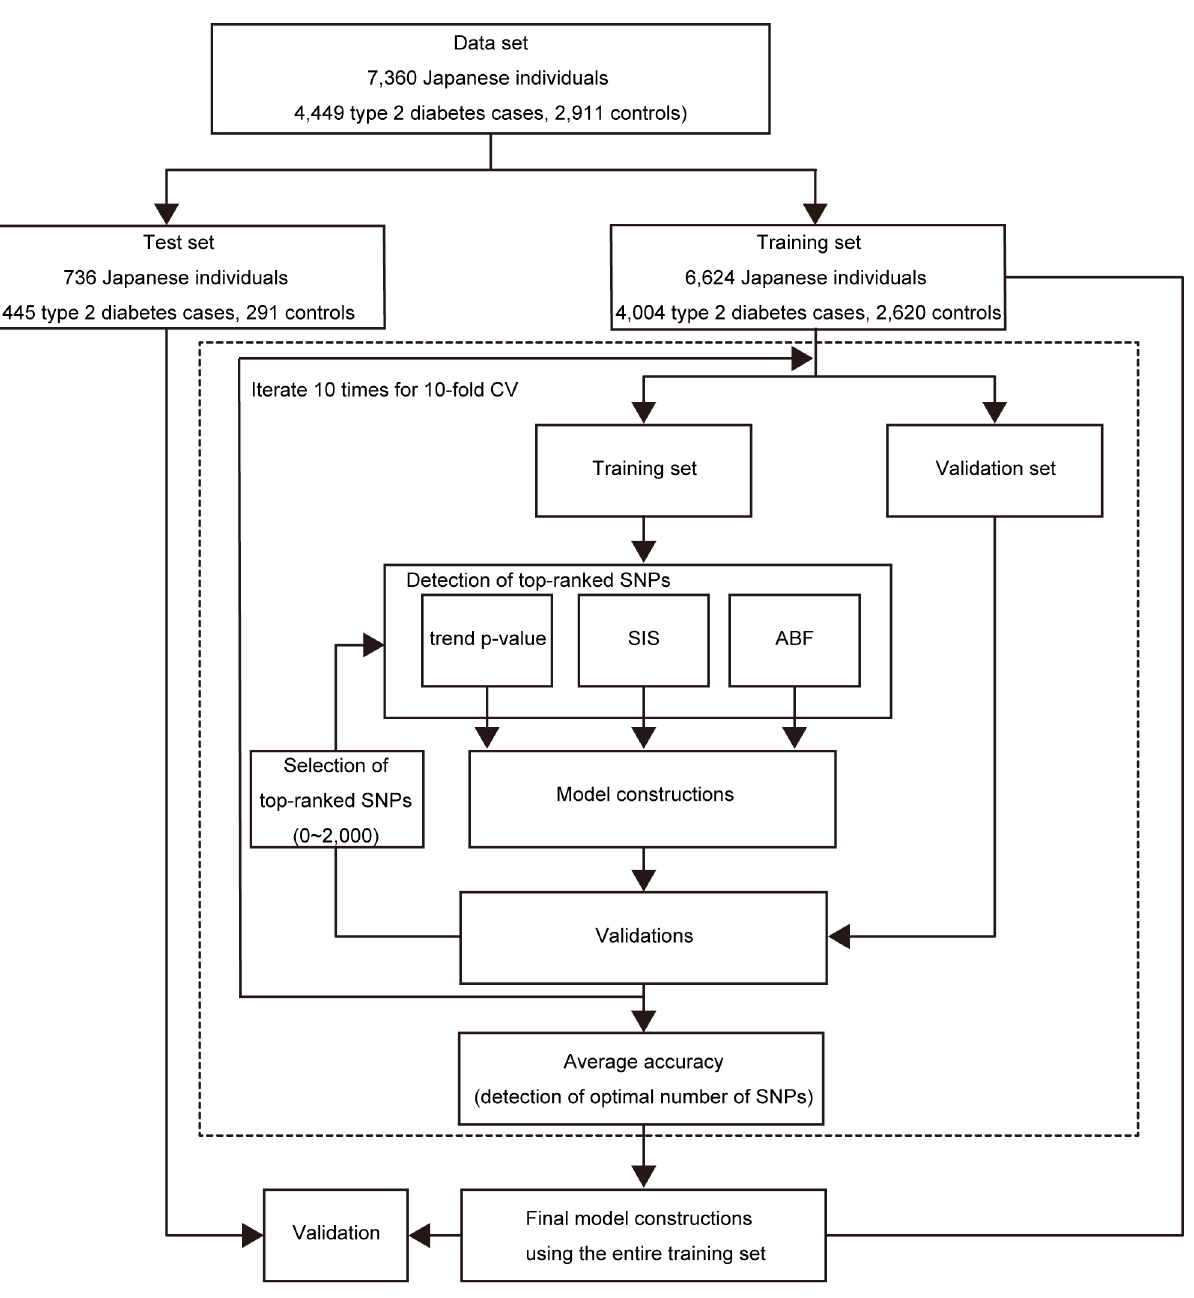
Figure 1. Outline of the risk prediction model construction and validation.